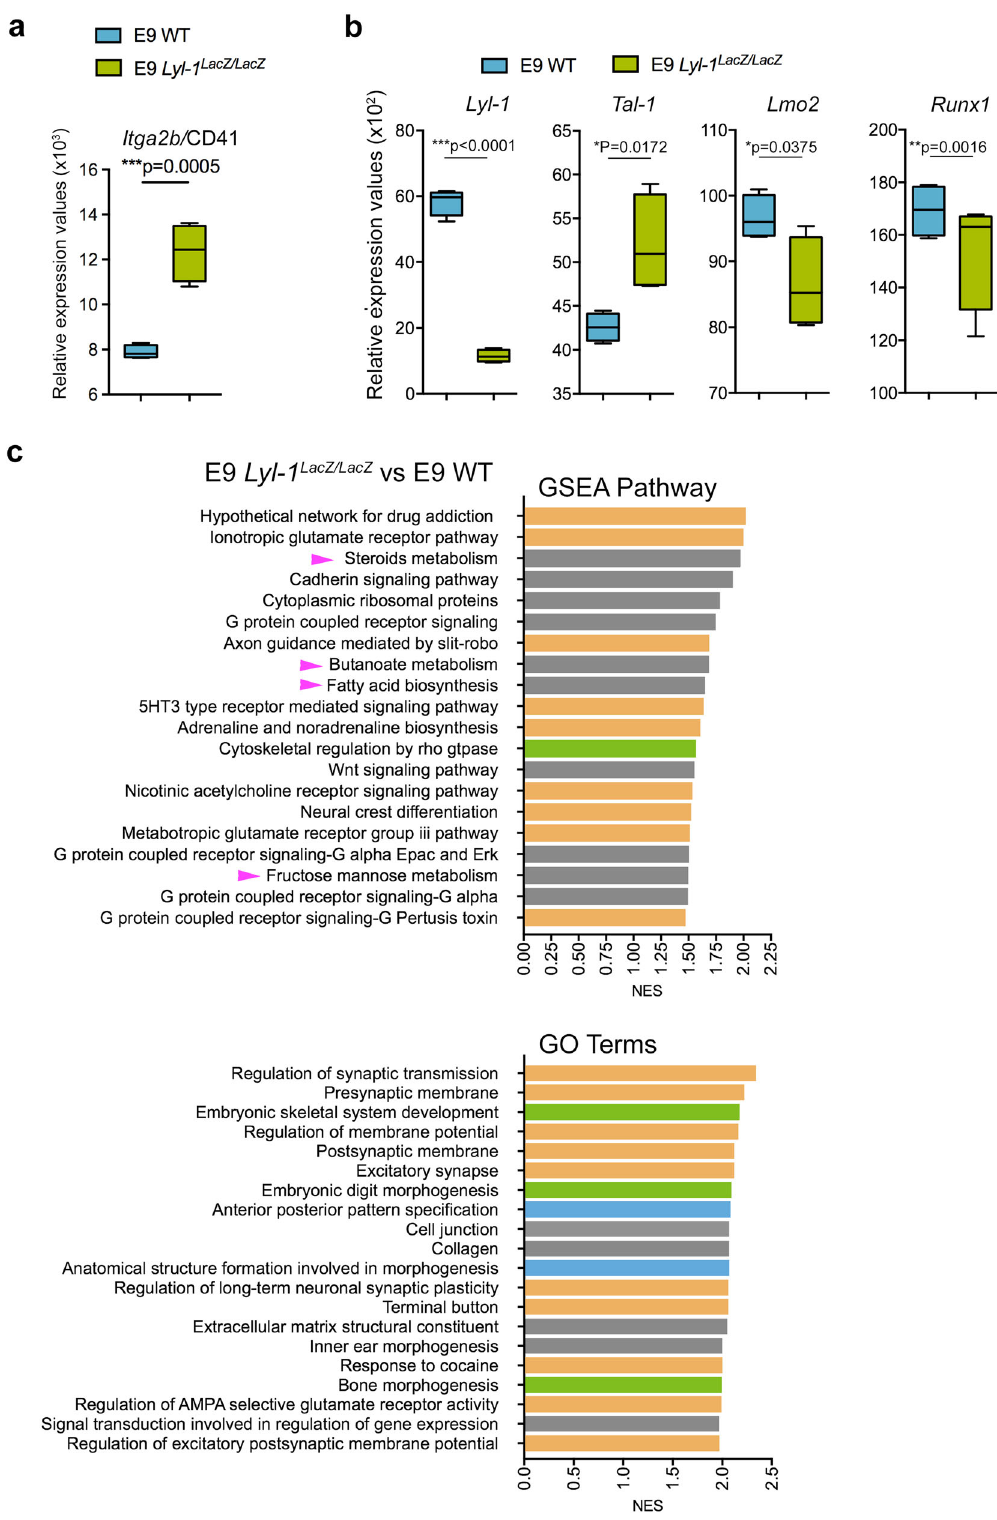
Fig. 3 Lyl-1 regulates the production of E8 M Φ Prim progenitors. a Relative expression levels of the CD41 coding gene Itg2b in WT and Lyl-1 LacZ/LacZ M Φ - progenitors at E9 (error bars show mean ± s.e.m.; unpaired t -Test, two-tailed). b Relative expression levels of transcription factors regulating hematopoietic progenitor emergence in Lyl-1 LacZ/LacZ M Φ -progenitors compared to WT at E9 (Error bars show mean ± s.e.m.; unpaired, two-tailed t -Test). c GSEA pathways (FDR q -value <0.29) and GO terms (FDR q -value < 0.01) enriched in E9 Lyl-1 LacZ/LacZ compared to E9 WT M Φ -progenitors. Highlighted are the pathways speci fi cally related to embryo patterning (blue) and to the development of skeletal (green) and nervous systems (yellow). Pink arrows point to changes related to metabolic